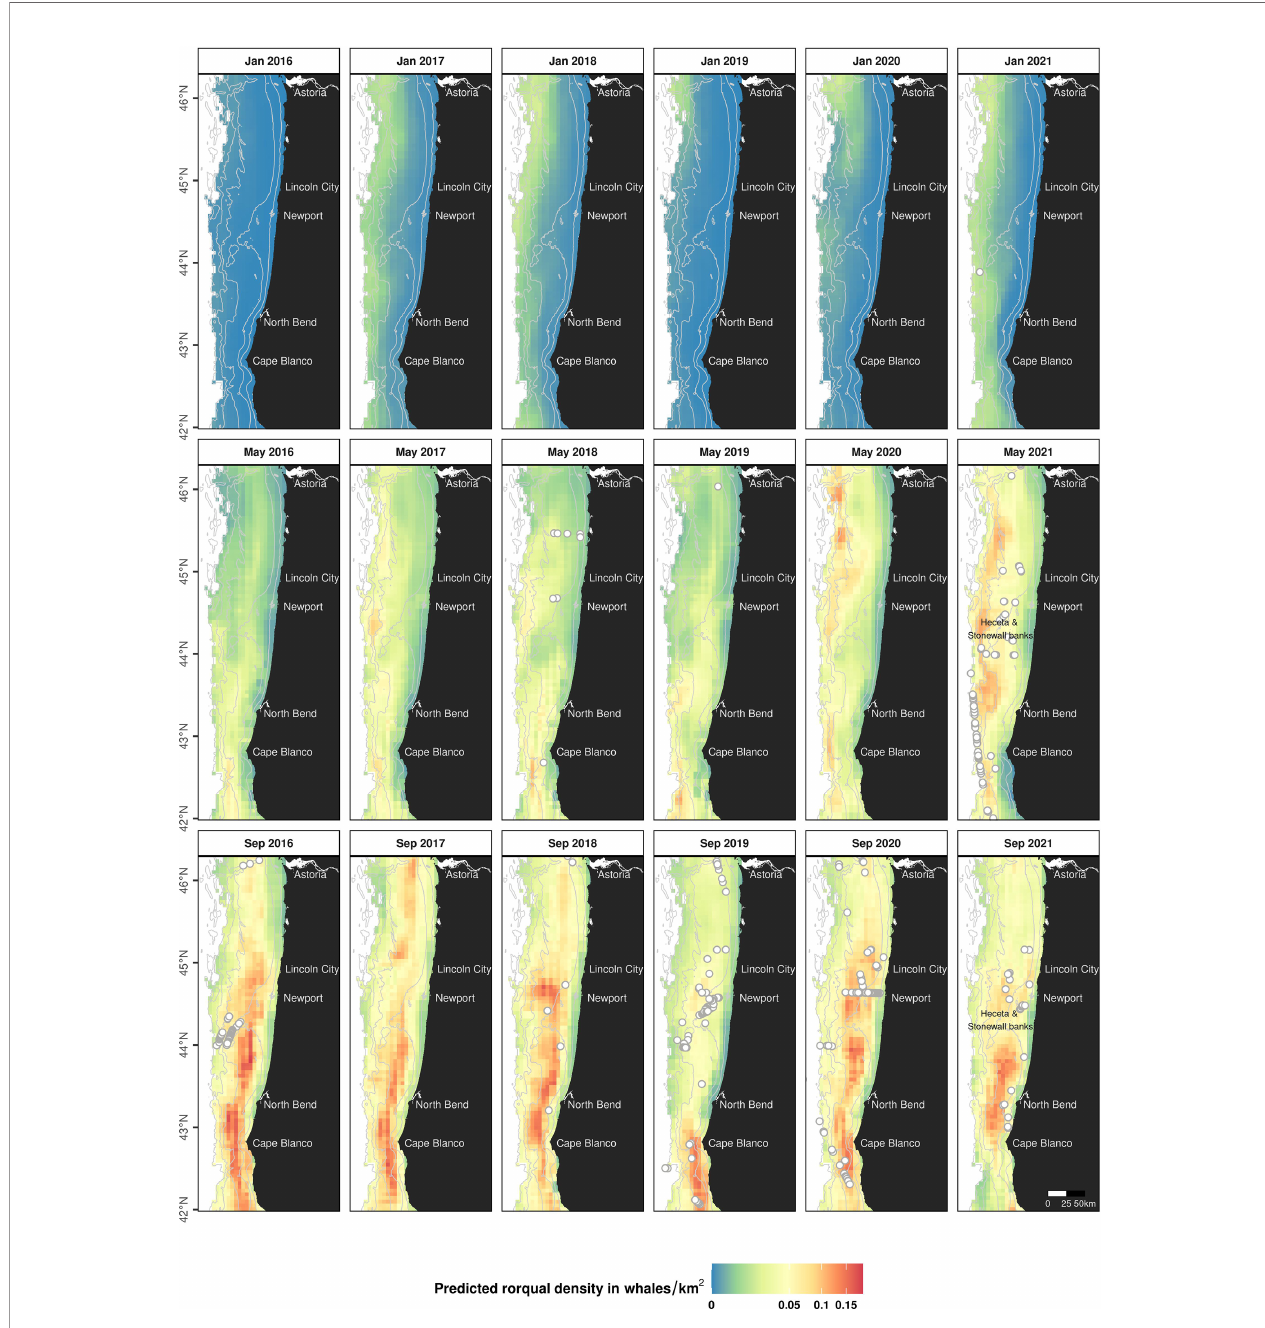
FIGURE 6 | Predicted seasonal densities of rorqual whales for the months of January, May and September, 2016 to 2021. Densities are represented on a colored scale (square-root transformed gradient). Land is shown in black. Isobaths (50, 100, 500, 1,000 and 1,500 m deep) are represented with grey lines. Grey circles mark the position of observed rorqual groups during each month x year from shipboard and helicopter surveys used to train the models. The absence of observations may be due to an absence of survey effort. This fi gure is also available in a color-blind-friendly palette in Supplementary Figure S18